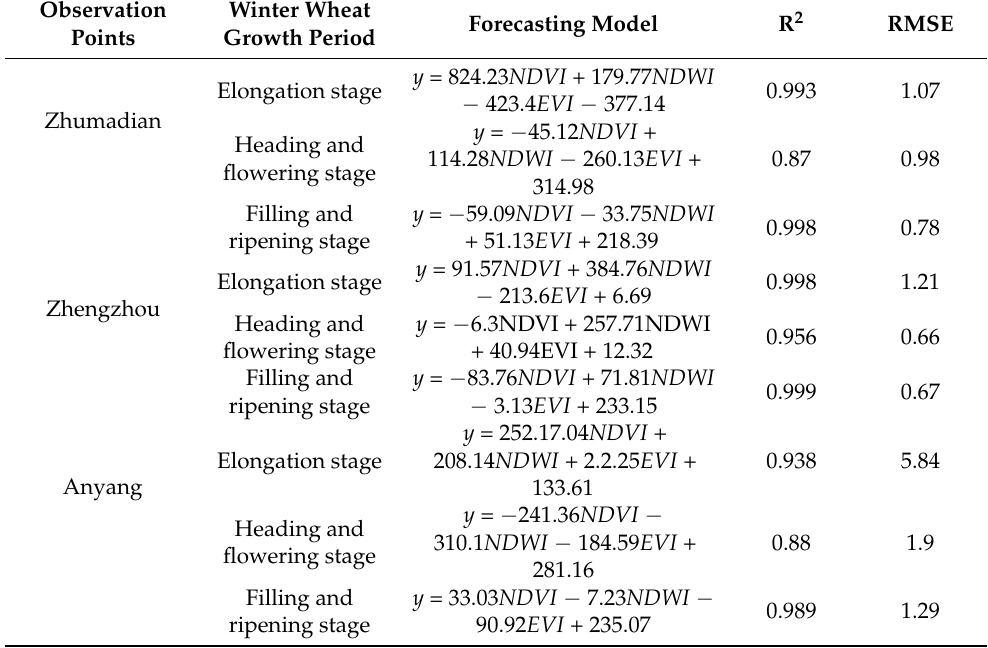
Table 5. Model of forecasting varying growth stages of winter